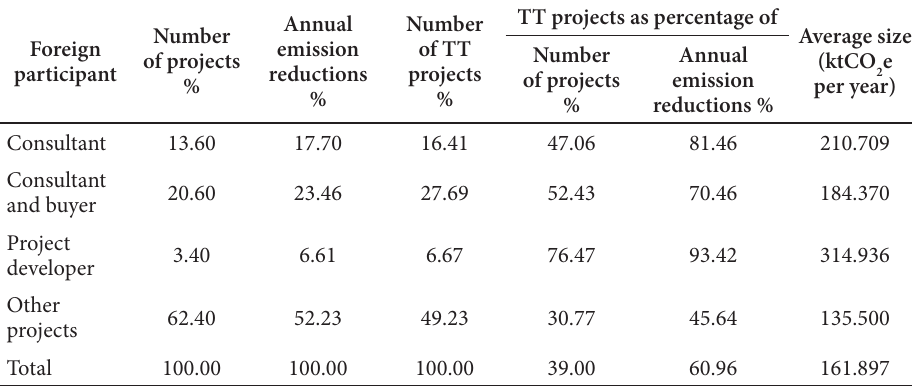
Table 4. Foreign participant